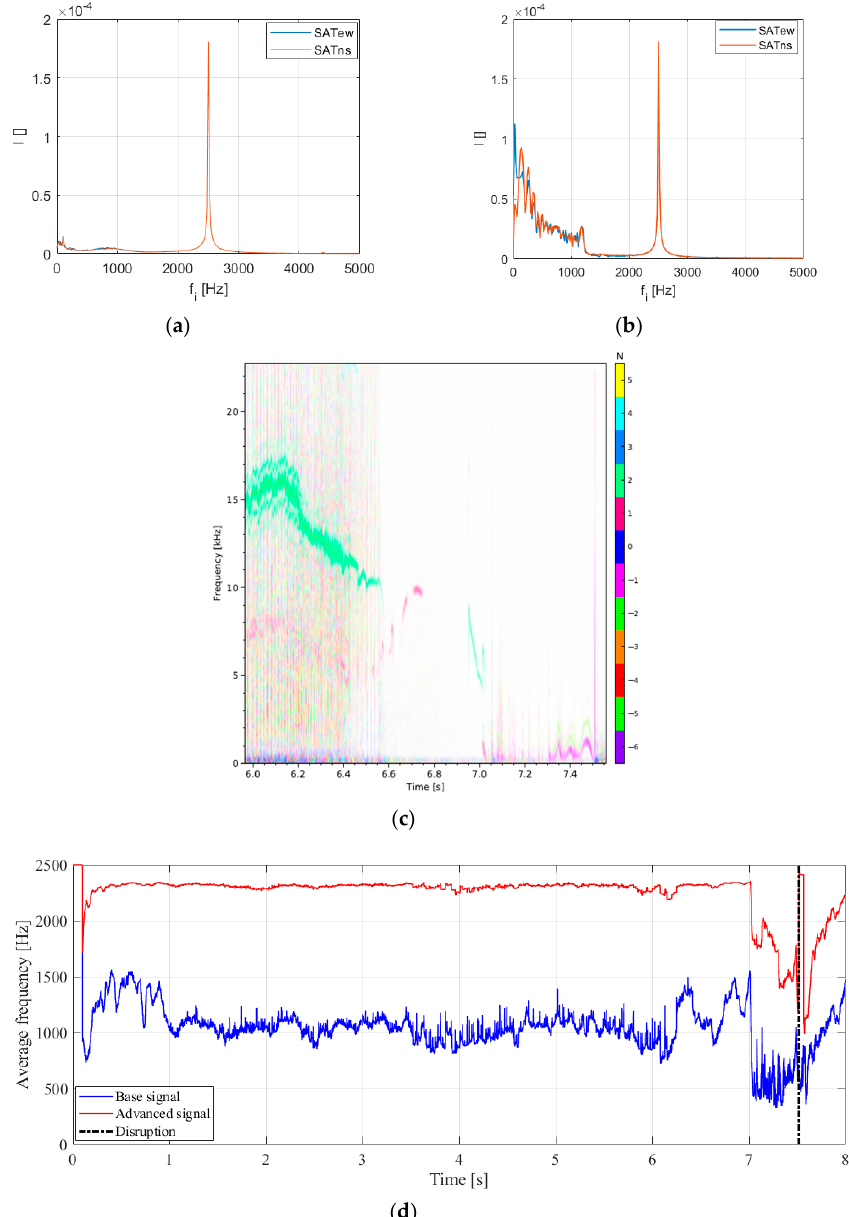
Figure 6. ( a , b ) Exemplificative spectra obtained from Bew and Bns for the discharge 30492 and the averaged frequency indicator evaluated during the whole pulse. ( a ) Same averaged spectra as in Figure 4b, but showing also the frequency of the sinusoidal driving term. Spectra are dominated by the ELMs and the added sinusoidal term locks the averaged frequency estimator around 2.5 KHz as it can be observed in ( d ). ( b ) Same averaged spectra as in Figure 4c, evaluated in a time window close to the disruption. The effect of the added term becomes secondary and the estimator in ( d ) follows the slowing down of the mode. ( c ) Mirnov coil spectrogram between 6s up to the time instance of the disruption at 7.516 s. A n = 2 mode oscillates at a frequency higher than 5 kHz before 7.0 s; from that instant onward an evident activity can be observed also due to n = 1. ( d ) Evaluation of the averaged estimator (6) considering or not the driving sinusoidal function. It can be observed how the added term locks the signal to a stable reference. The black dashed line provides the time instance of the